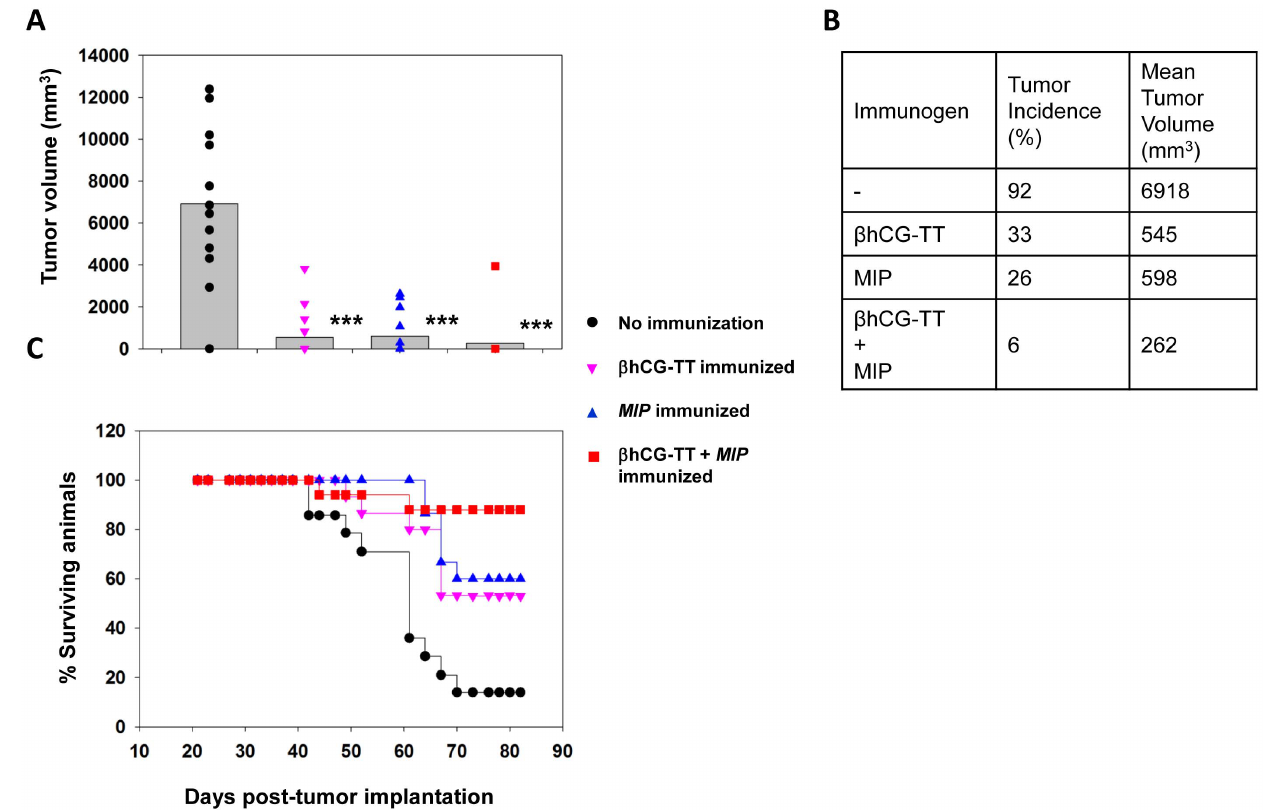
Figure 10. Effect of immunization on tumor volume, incidence and survival. (A, B) Tumor volume and incidence post-tumor implantation of SP2/O cells in BALB/c mice. Data on b hCG-TT, b hCG-TT + MIP , or MIP- immunized animals is depicted along with control (non-immunized) mice on Day 43 post-tumor cell implantation. In (A), each point represents an individual animal and bars denote geometric means. ***p # 0.001 versus the non- immunized group. (C) Survival curves for control animals and animals immunized with the different formulations, as indicated. n=16.